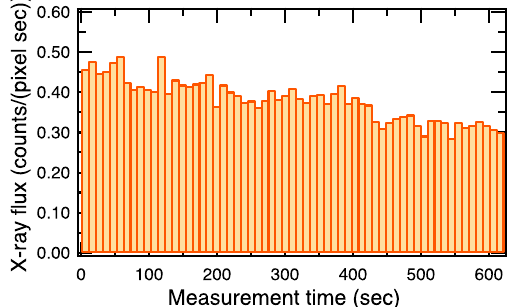
FIG. 26. Setup of the LCS x-ray imaging at the cERL.